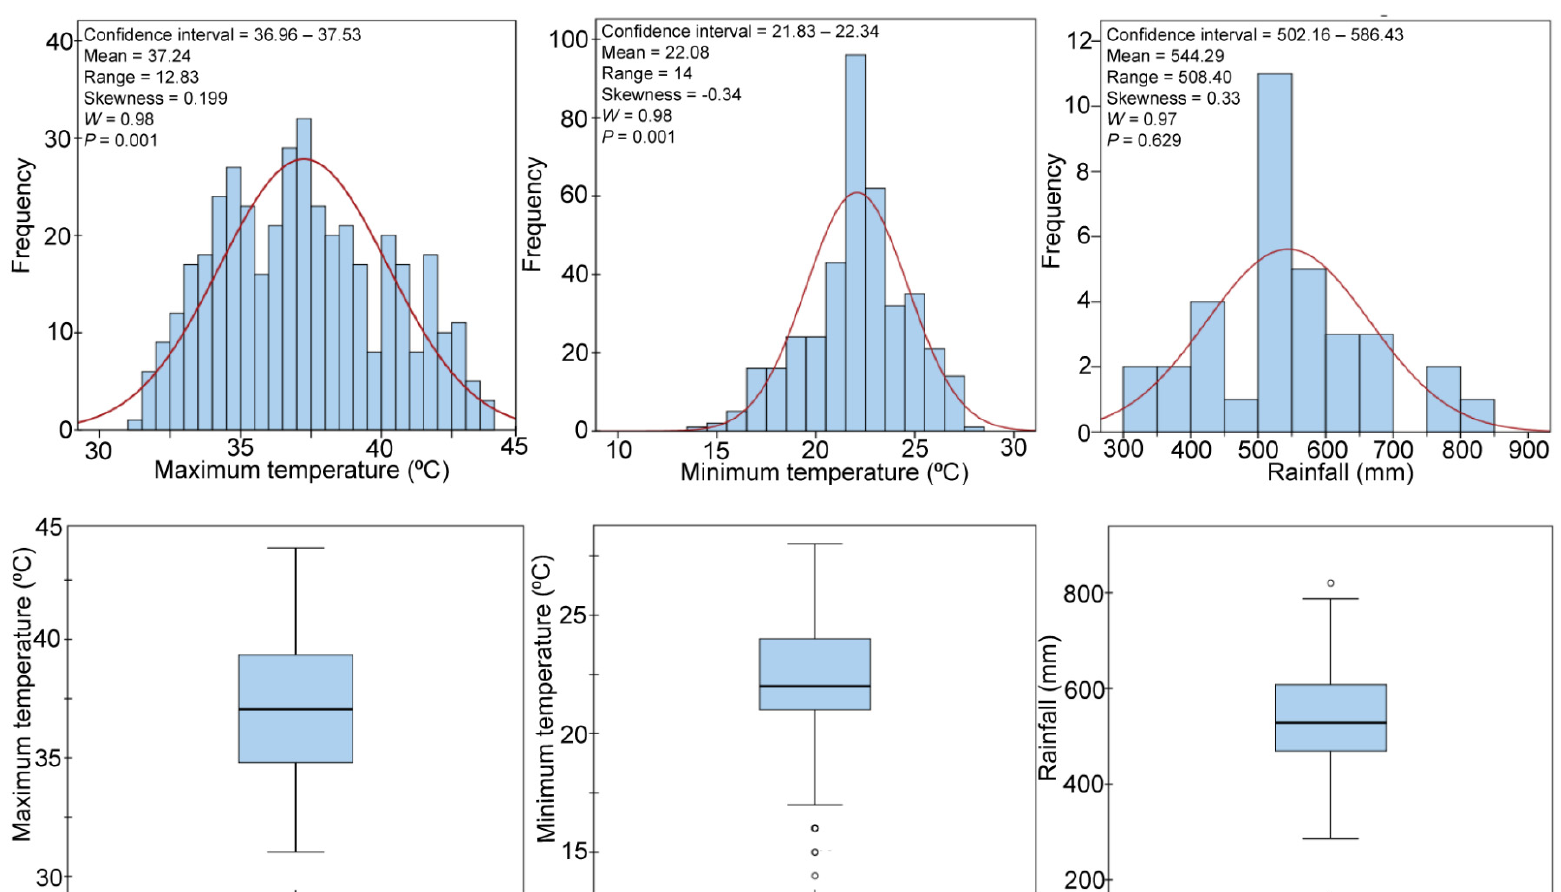
Figure A1. Histogram, normal distribution, and boxplot fitted for minimum (Tmin) and maximum (Tmax) temperatures (1984–2018) and rainfall (1980–2018) data obtained from the Gedaref meteorological station, Sudan. Circles in some boxplots represent individual outlier observations.